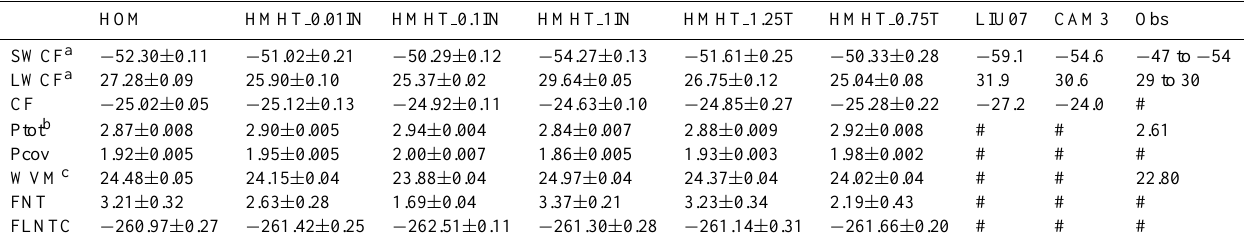
Table 3. Annual global mean shortwave cloud forcing (SWCF,W/m 2 ), longwave cloud forcing (LWCF,W/m 2 ), net cloud forcing (CF,W/m 2 ), total precipitation (Ptot, mm/day), convective precipitation (Pcov, mm/day), water vapor mass (WVM, kg/m 2 ), net incom- ing radiation at the top of the atmosphere (FNT,W/m 2 ), and clear sky net long wave radiation at the top of the atmosphere (FLNTC,W/m 2 , negative values mean outgoing) and their interannual variations (standard